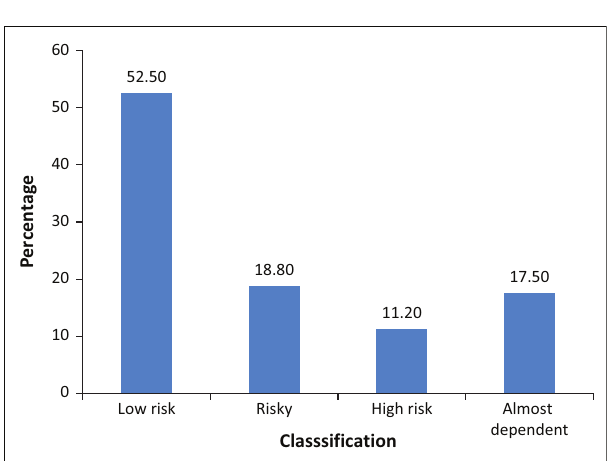
FIG URE 1: Alcohol Use Disorders Identification Test classification of alcohol use by respondents ( N = 314).